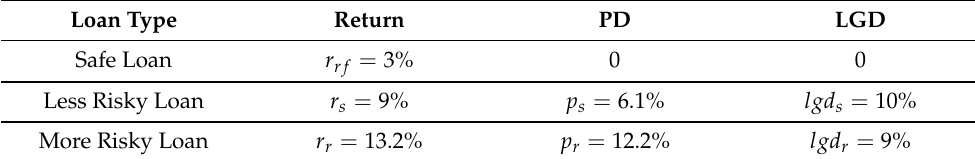
Table 3. Risk parameters for the three loans for the first example. Loan Type Return PD LGD